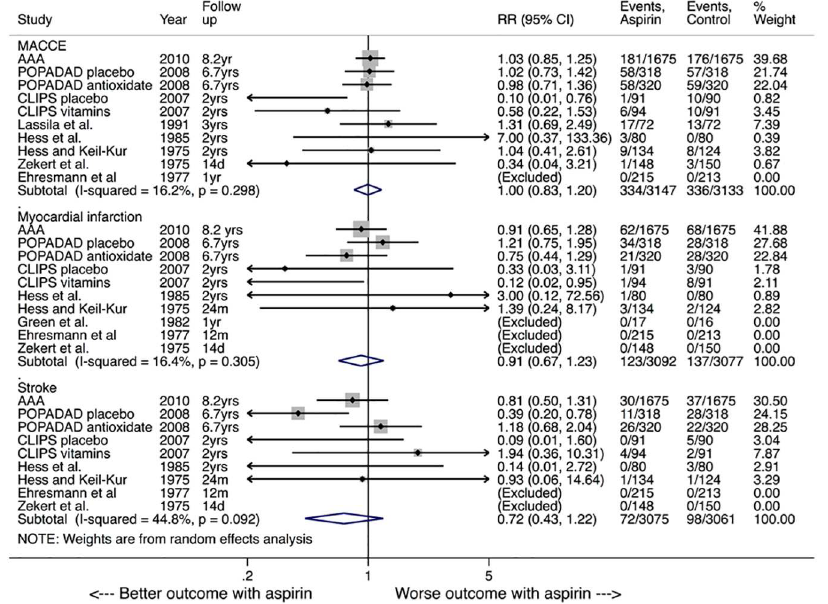
Fig 3. Random-effect summaryplot for major adversecardiac and cerebrovascular events (MACCE), myocardial infarction (MI) and stroke. The relative size of the data markers indicatesthe weight of the sample size from each study. CI = confidenceinterval, RR = risk ratio. P-values represent Chi-squaretest of heterogeneity.